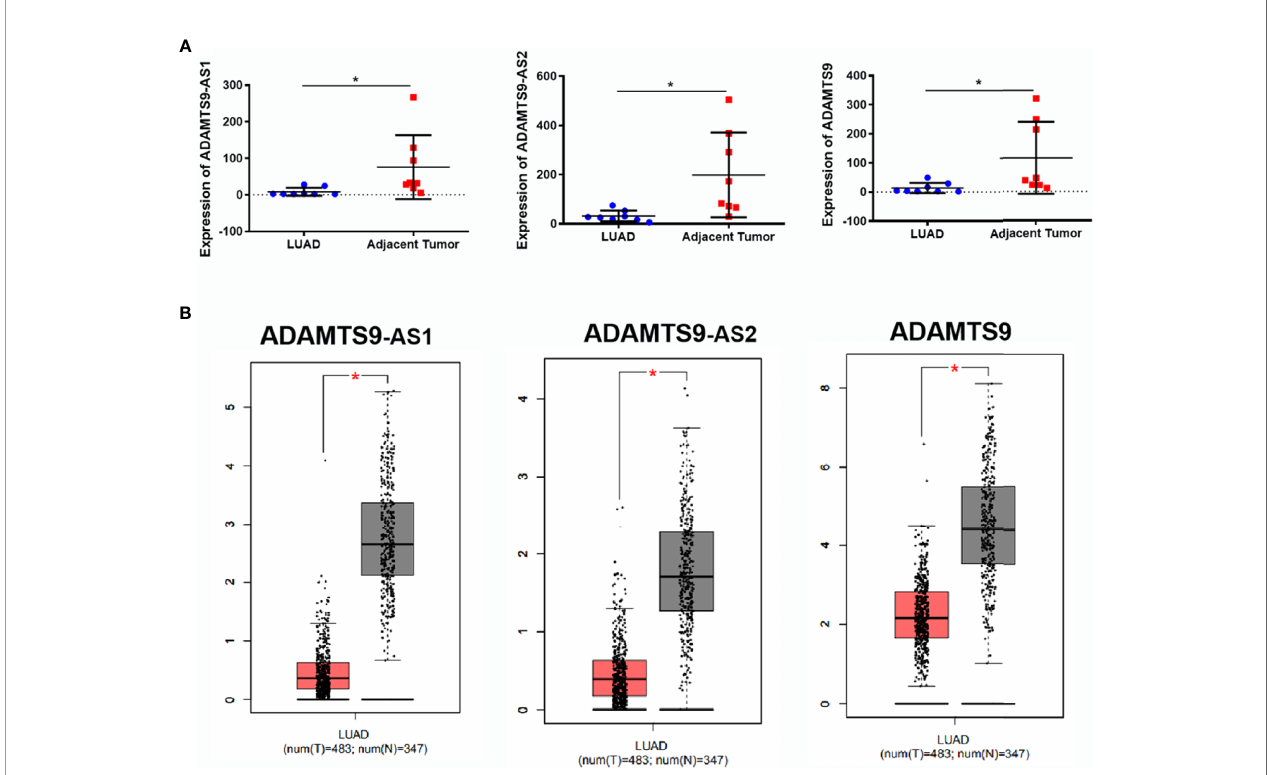
FIGURE 2 | The expression of ADAMTS9-AS1/ADAMTS9-AS2/ADAMTS9 in LUAD tissues. (A) The expression of ADAMTS9-AS1/ADAMTS9-AS2/ADAMTS9 in LUAD tissues were analyzed by the GEO database. (B) The expression of ADAMTS9-AS1/ADAMTS9-AS2/ADAMTS9 in LUAD tissues were analyzed by the GEPIA database. *p < 0.05. LUAD, lung